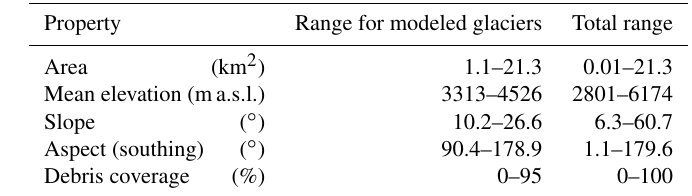
Table 2. Morphological properties of the 26 glaciers modeled with TOPKAPI-ETH